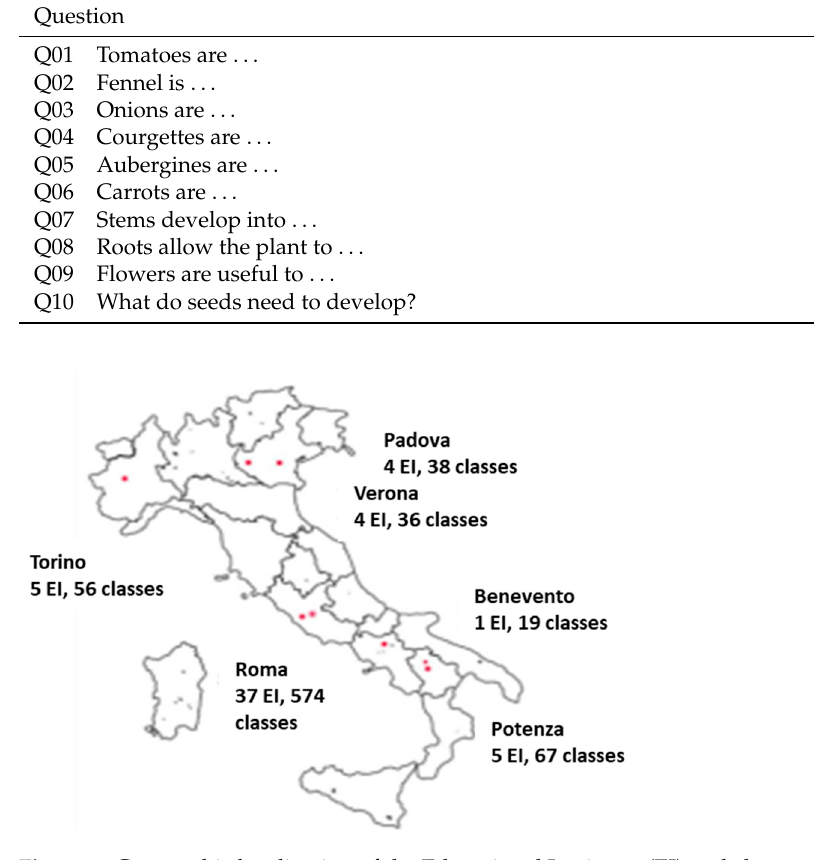
Figure 1. Geographic localization of the Educational Institutes (EI) and classes participating in the implementation of MaestraNatura program.